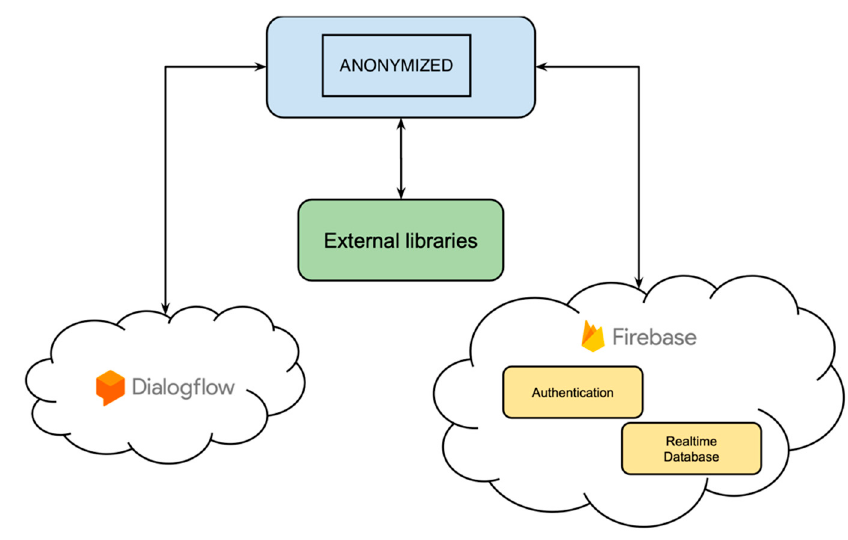
Figure 4. The developed app’s system architecture.